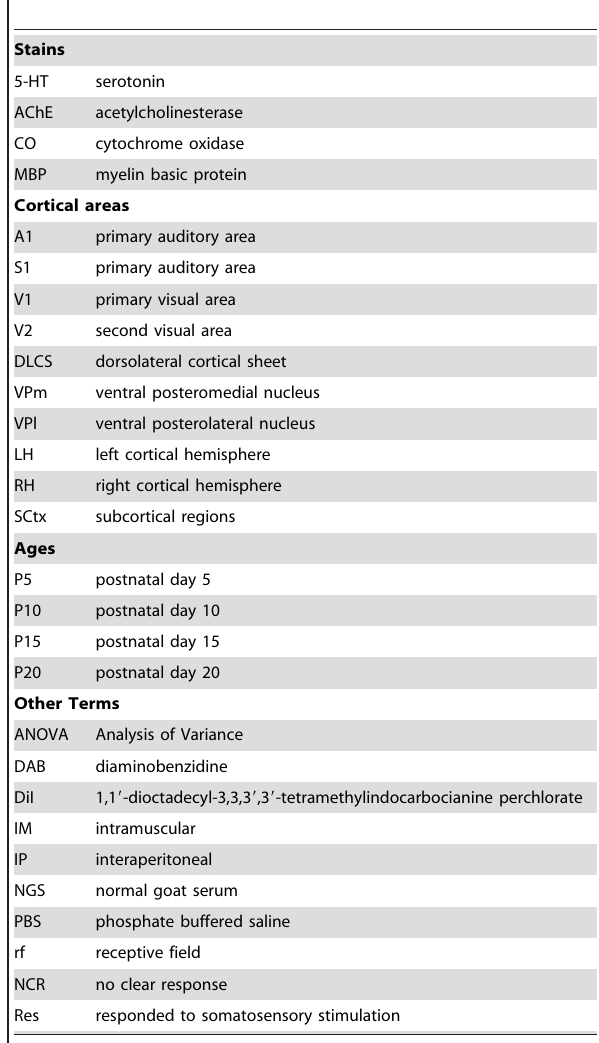
Table 1. List of